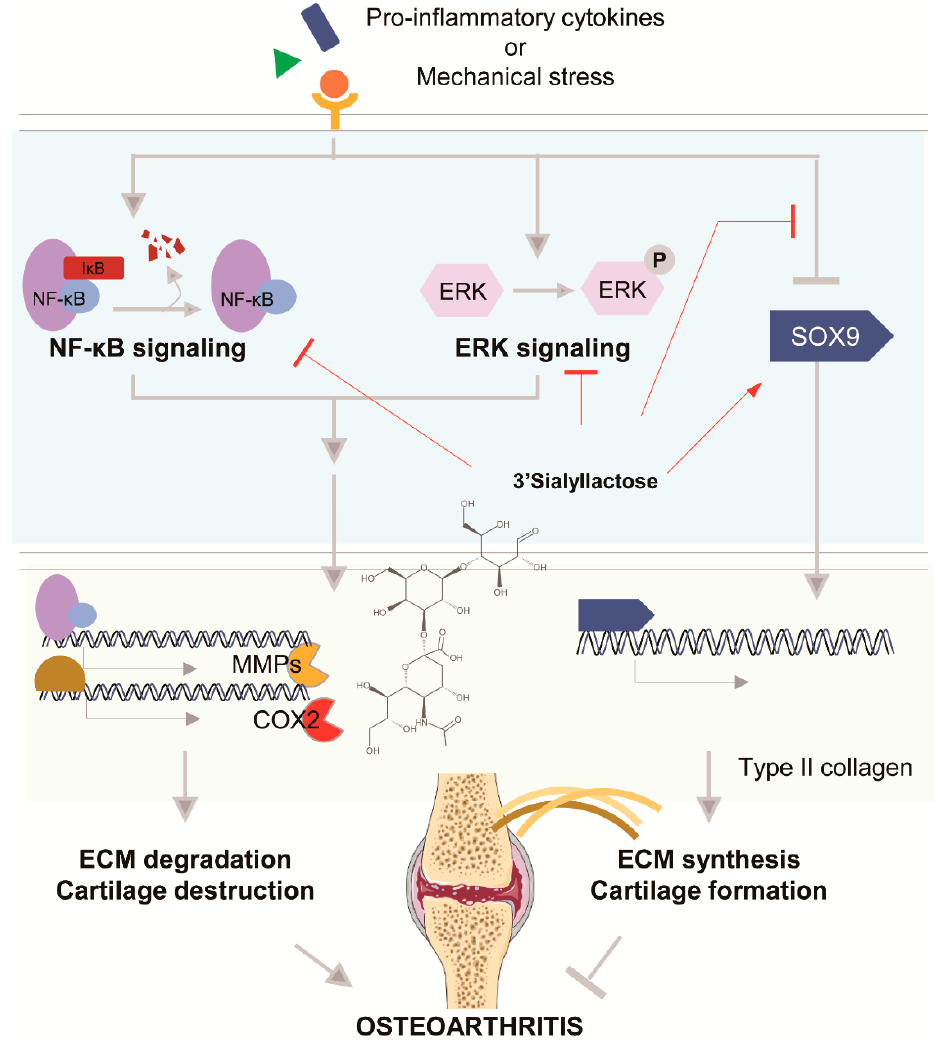
Figure 4. Structure of 3 ′‐ sialyllactose. Triptolide ( Tripterygium wilfordii Hook. f.)